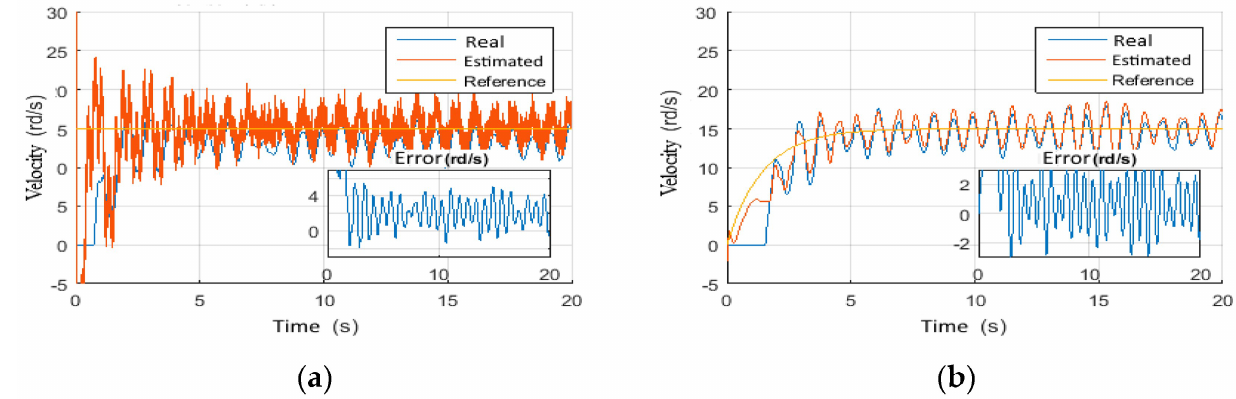
Figure 37. Noised inputs of Top drive for Scenario-11: ( a ) Velocity, ( b ) Current.